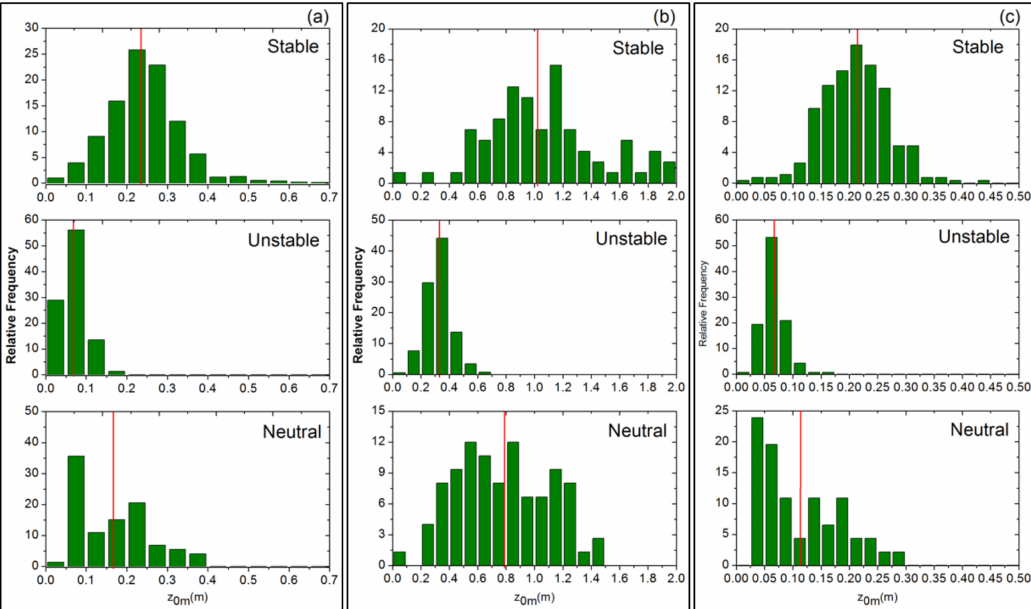
Figure 8. Relative frequency of z 0m for stable, unstable and neutral conditions at the ( a ) Arou site; ( b ) Guantan site and ( c ) Daman site. The vertical red lines in each image indicate the mean